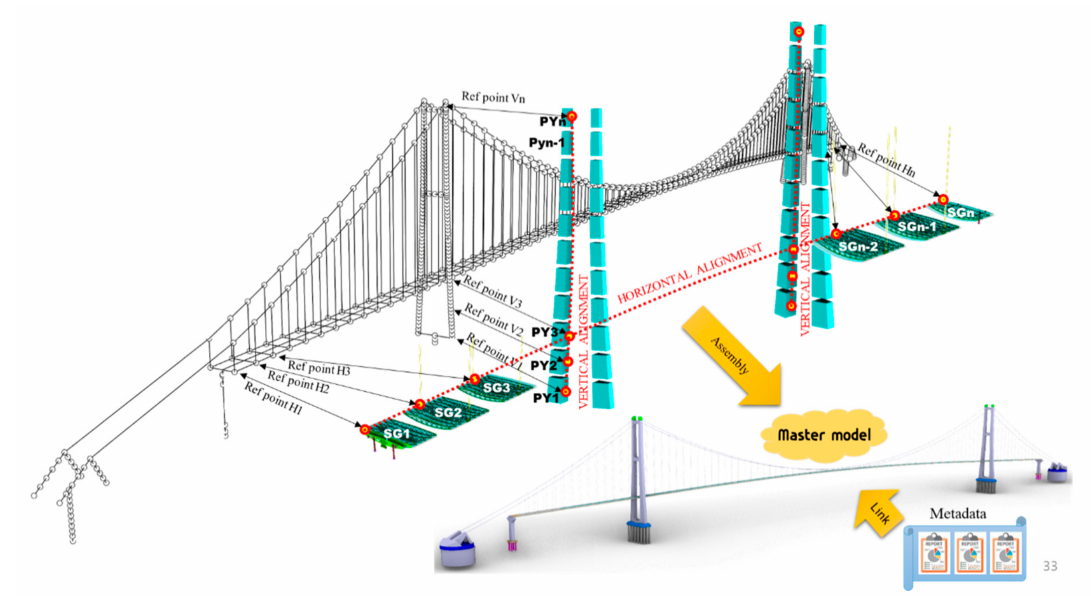
Figure 9. 3D bridge alignment for a suspension